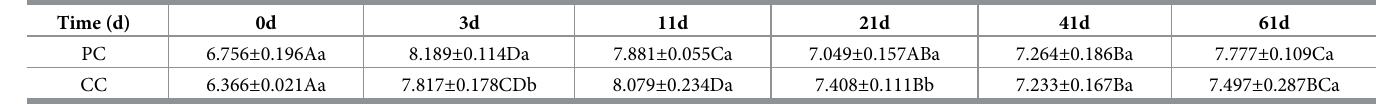
Table 4. Changes of viable bacteria number.